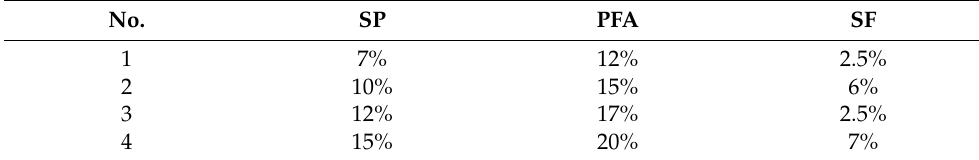
Table 8. The SP, PFA, and AF content of the validation experiments.